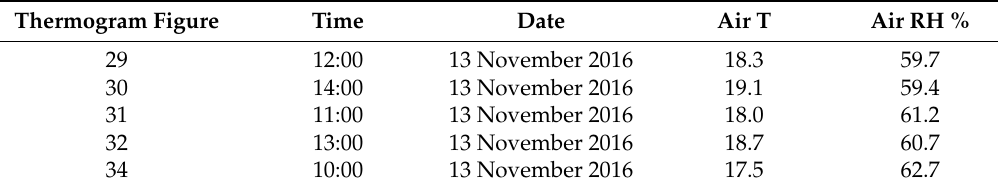
Table 3. Climatic conditions during IRT